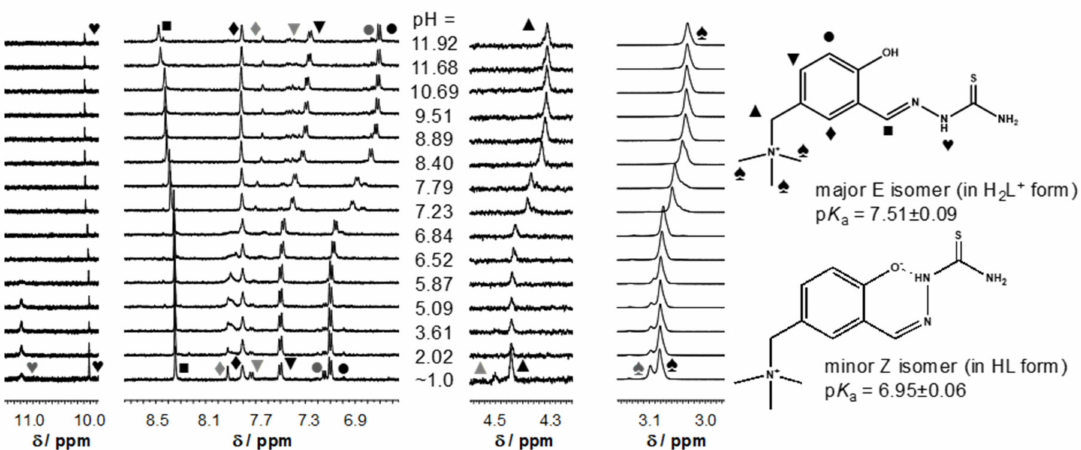
Figure 5. 1 H NMR spectra of the proligand [H 2 L H ]Cl (with di ff erent zooming of the selected regions for the better visibility) at various pH values with symbols used for proton resonances assignment in case of the major E isomer (black symbols) and minor Z isomer (grey symbols) and their p K a values calculated from the chemical shift changes ( c L = 200 µ M; I = 0.1 M (KCl); t = 25 ◦ C; 10% ( v / v ) D 2 O / H 2